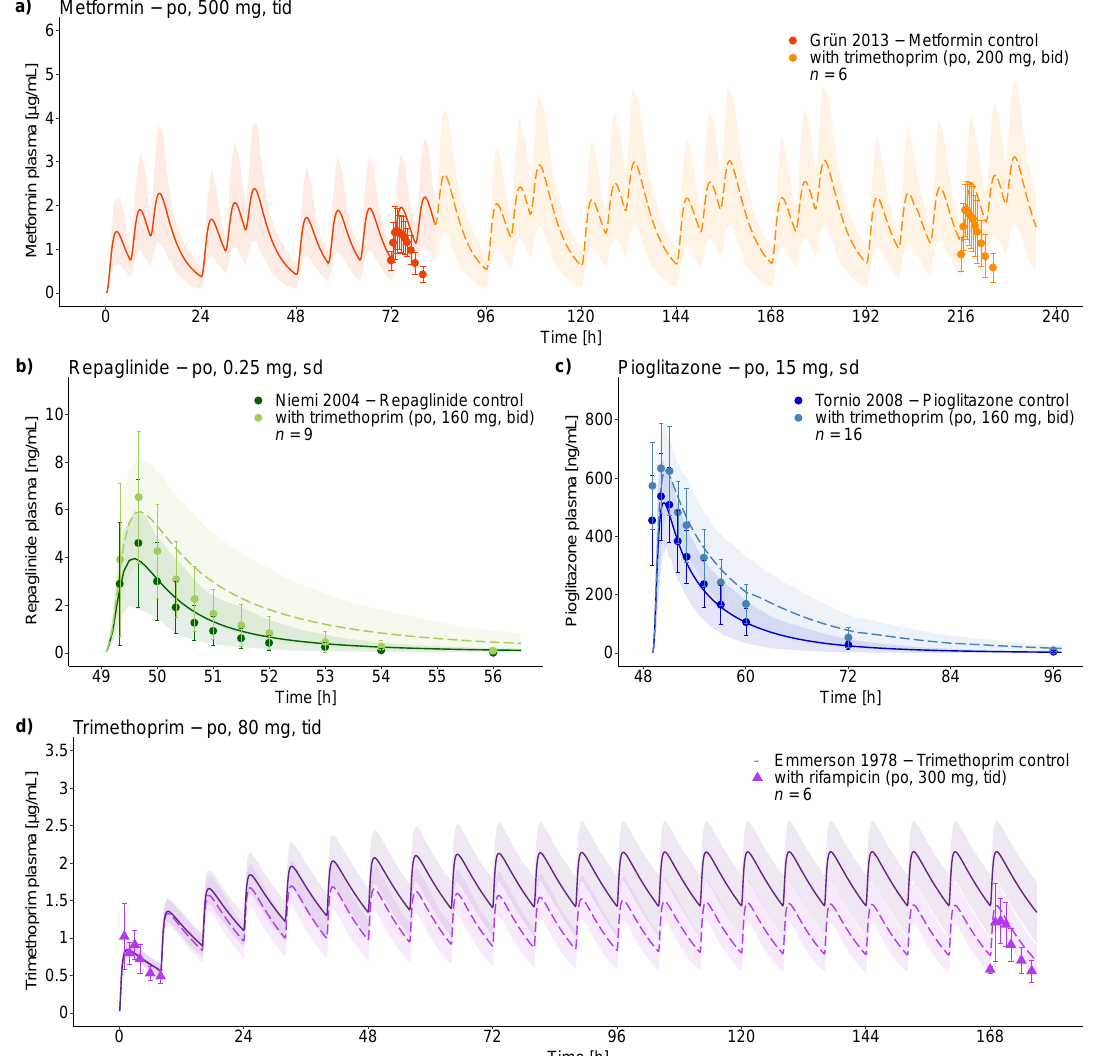
Figure 6. Trimethoprim DDI victim drug plasma profiles. Population predictions of victim drug plasma concentration–time profiles of the ( a ) trimethoprim–metformin, ( b ) trimethoprim–repaglinide, ( c ) trimethoprim–pioglitazone, and ( d ) rifampicin–trimethoprim DDIs, compared to observed data [5–7,16]. Population prediction arithmetic means are shown as lines (solid, victim drug alone and dashed, victim drug during perpetrator co-administration); the shaded areas illustrate the respective 68% population prediction intervals. Observed data are shown as triangles (training dataset) or dots (test dataset) ± standard deviation. Perpetrator application starts at ( a ) 83 h or ( b – d ) 0 h. Details on the study protocols and model simulations of all clinical DDI and DDGI studies used to evaluate the DDI performance of the trimethoprim model are provided in the Supplementary Materials. bid, twice daily; po, oral; sd, single dose; tid, three times